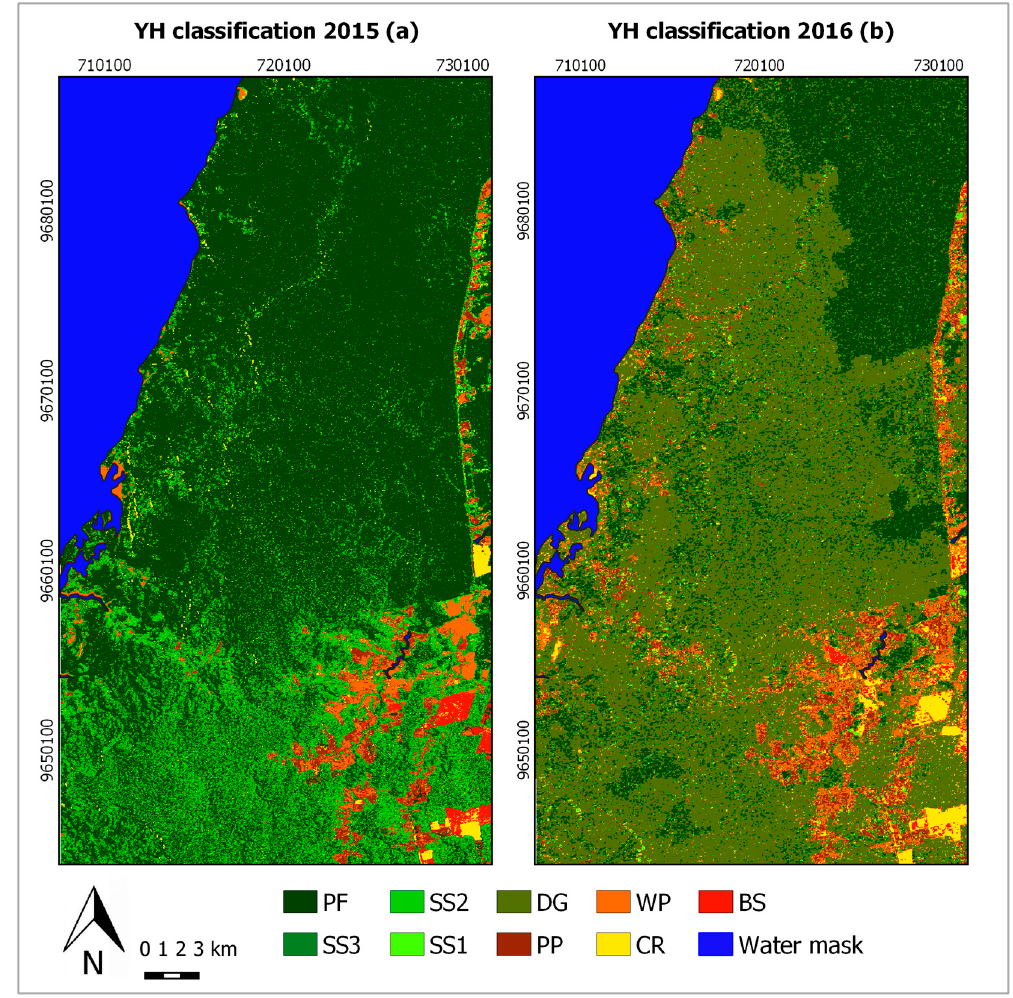
Figure 10. Land use, land cover, and forest degradation classification maps of the study area from 2015 ( a ) and 2016 ( b ), based on Yamaguchi (YH) decomposition. For LULC class identification, see Table 1.